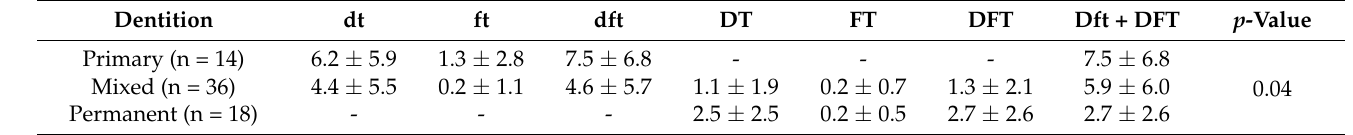
Table 3. DMFT and dmft scores distributed by dentitions.